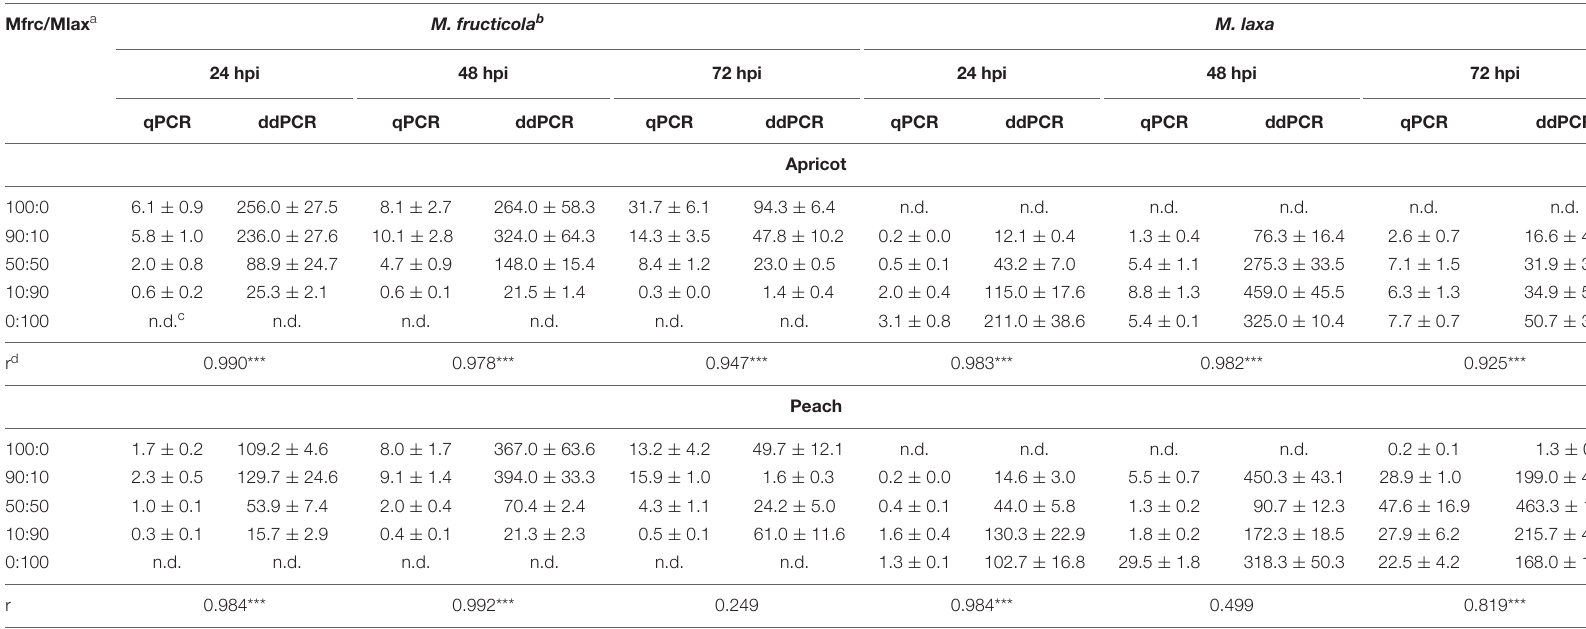
TABLE 3 | Comparison among quantity of Monilinia fructicola and M. laxa DNAs in duplex-qPCR (ng) and duplex-ddPCR (copies µ L − 1 ) assays on artificially inoculated apricot and peach fruits. Mfrc/Mlax a M. fructicola